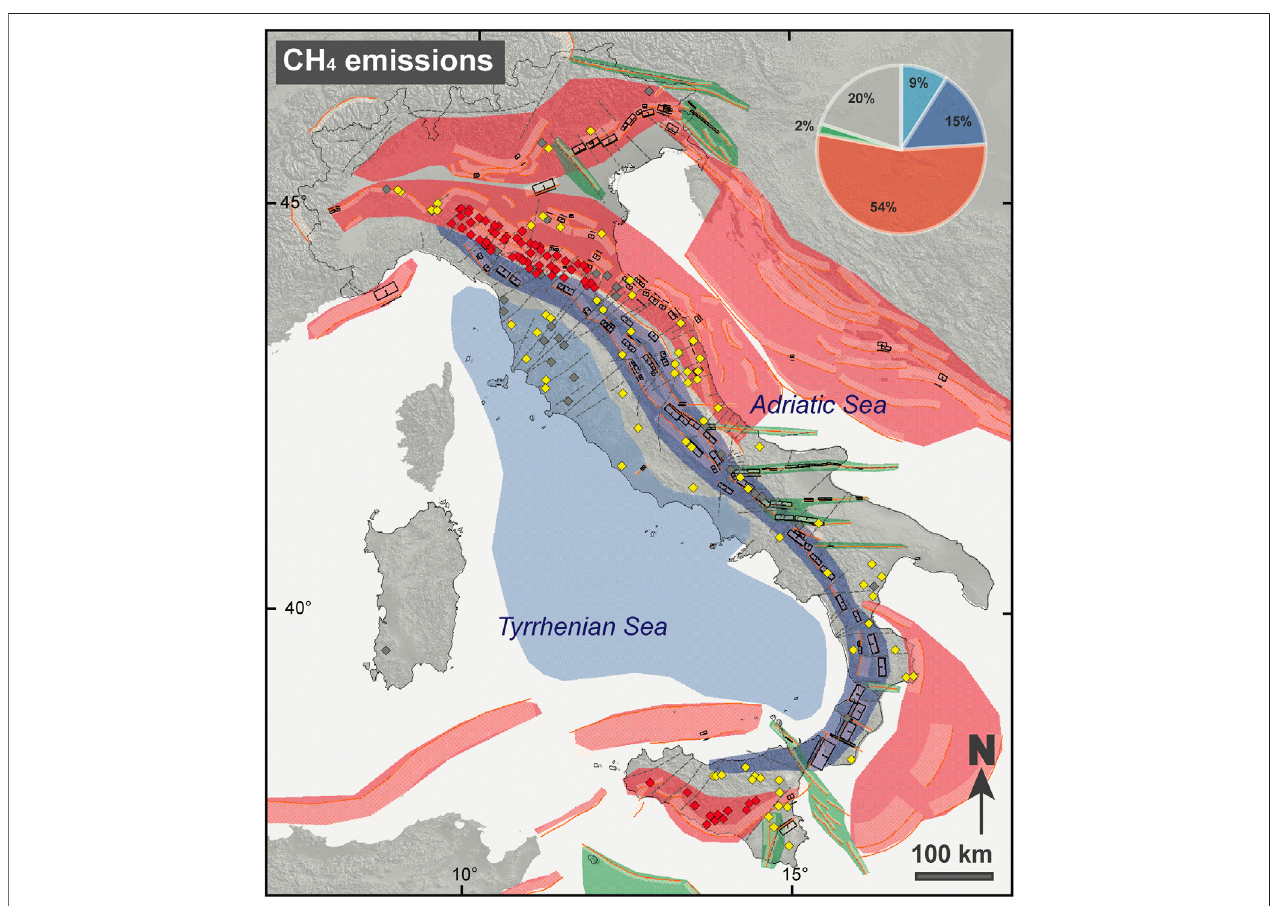
FIGURE 6 | Distribution of CH 4 emissions (see Gas Seeps and Mud Volcanoes , CH 4 Emissions and Mud Volcanoes and CH 4 Emissions and Mud Volcanoes: The Signature of Contractional Domains Sections). Tectonic domains, seismogenic sources and transverse lineaments are shown as in Figure 2 . Removeddatapointsareshowningrey.Selecteddatapointsareshowninrediftheyarediscussedinthetext,otherwiseinyellow.Thepiechartshowsthedistributionof CH 4 emissions in the different active tectonic domains (see Table 1 ). Notice that 54% of these emissions fall in areas of active contraction.